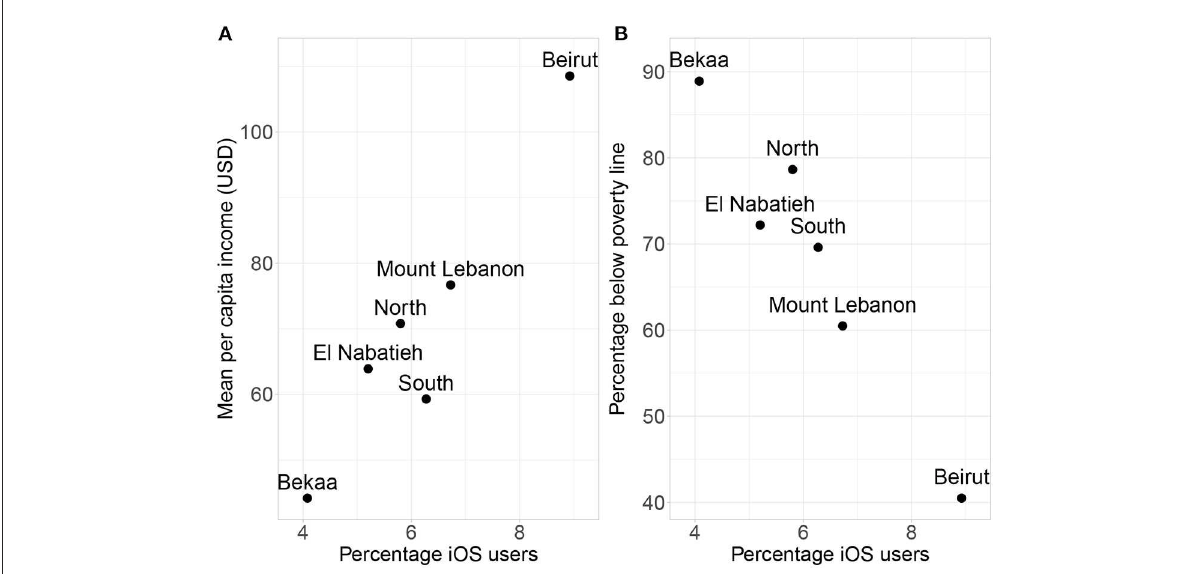
FIGURE5 Scatter plots of the percentage of Facebook users from the refugee community who use an iOS device against mean per capita income (A) and percentage below poverty line (B) .